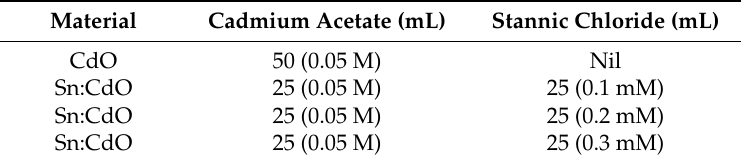
Table 1. Prepared Sn:CdO thin films with three different concentrations and three different volumes.